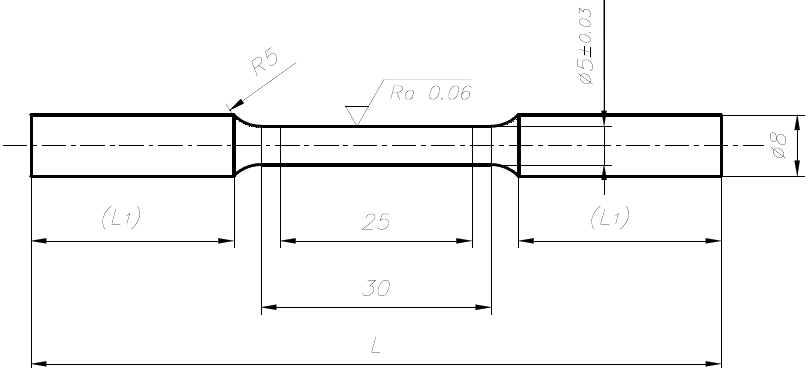
Figure 6. Dimensions (in mm) of samples intended for mechanical tensile tests (L—~95 mm, L 1 —~30 mm).